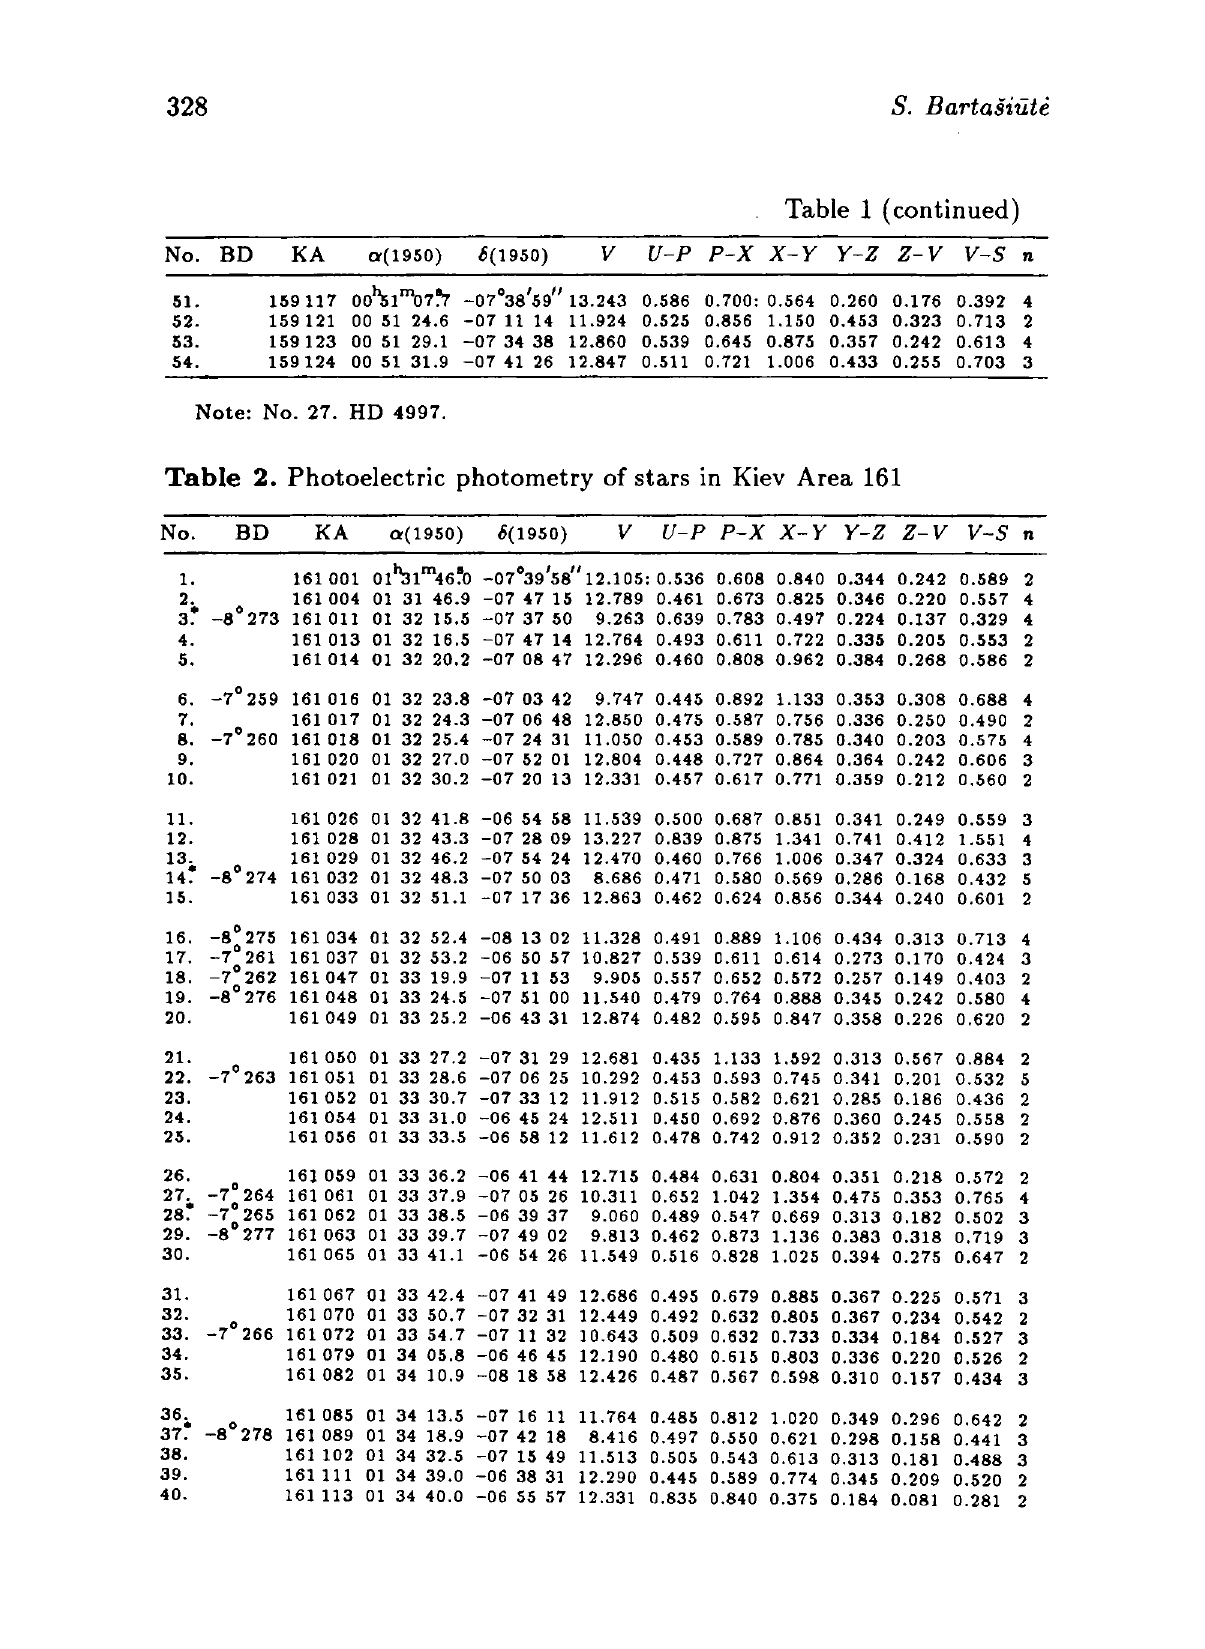
Table 2. Photoelectric photometry of stars in Kiev Area